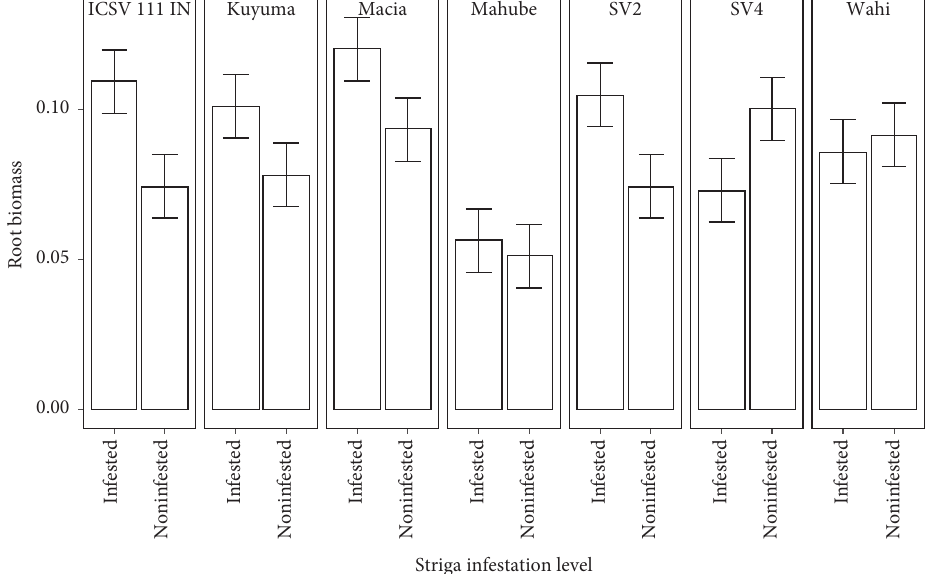
Figure 7: Effect of genotype and Striga on sorghum root biomass (kg pot − 1 ). Error bars represent LSD at p < 0 .